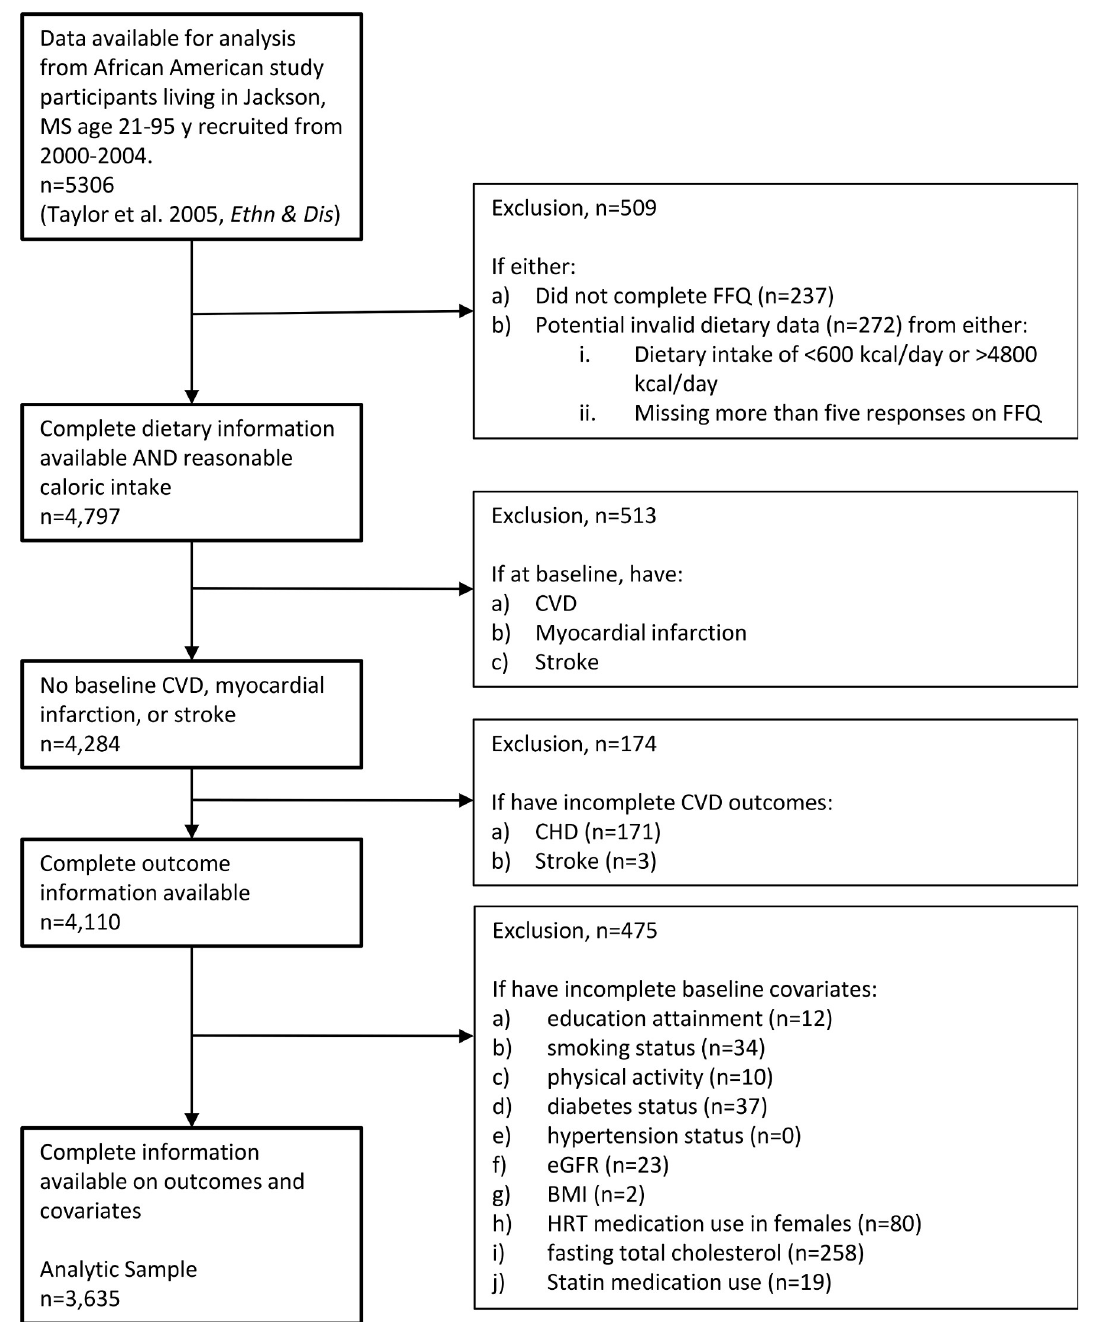
Fig 1. Participant selection flowchart. There were no missing data for age, sex, and total energy intake. Abbreviations: BMI, body mass index; CVD; cardiovascular disease; eGFR, estimated glomerular filtration rate; FFQ, food frequency questionnaire; HRT, hormone replacement therapy; MS,